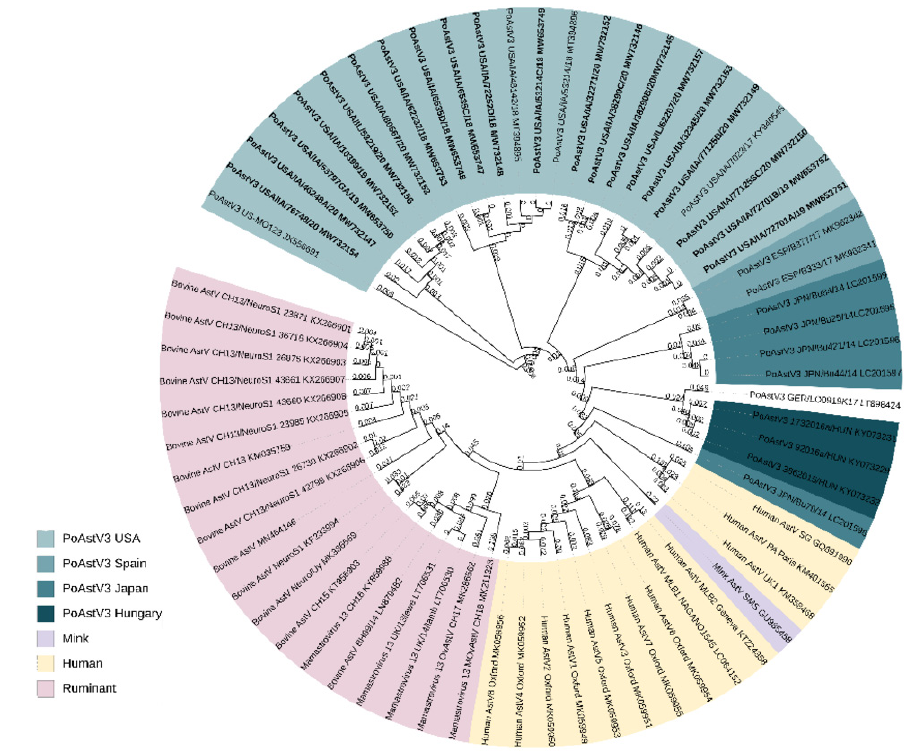
Figure 1. Phylogenic tree of selected full-genome neurotropic Mamastrovirus strains and 20 novel full-genome PoAstV3 strains identified in this study (bold). All novel PoAstV3 strains identified in this study clustered with PoAstV3 strains previously described. Nucleotide sequences were aligned using ClustalO webserver under default settings. The phylogenic tree was generated using the neighbor-joining algorithm using MEGAX and rendered with iTOL. The ORF1a, ORF1ab, and ORF2 of USA strains are composed of 855, 1356, and 809 residues, respectively. The nt percent identity of USA strains varies from 89.74–100%, 91.09–100%, and 90.71–100% for ORF1a, ORF1ab, and ORF2, respectively. The aa percent identity of USA strains vary from 95.26–100%, 96.3–100%, and 93.51–100% for nsp1a, nsp1ab, and capsid protein, respectively (Table 2). Among all PoAstV3, the lowest nt /aa percent identity for ORF1a/nsp1a, ORF1ab/nsp1b and ORF2/capsid protein was 84.26/92.04, 85.94/93.26 and 64.44/64.05, respectively (Tables S3–S5). Among systems with multiple cases the sequence homology was the following: Farm/system B ( n = 4), ORF1a (99.68–99.96%), nsp1a (99.53–100%), ORF1ab (99.68–99.9%), nsp1ab (99.63–99.93%), ORF2 (99.76–99.92%), capsid protein (99.76–99.88%); Farm/system N ( n = 3) ORF1a (99.68– 99.96%), nsp1a (96.21–99.88%), ORF1ab (91.33–99.19%), nsp1b (97.04–99.85%), ORF2 (91.93%), capsid protein (94.74–100%); Farm/system C ( n = 2) ORF1a (90.65%), nsp1a (95.73%), ORF1ab (91.82%), nsp1b (96.45%), ORF2 (92.18%), capsid protein (94.61%) (Ta- bles S3–S5).